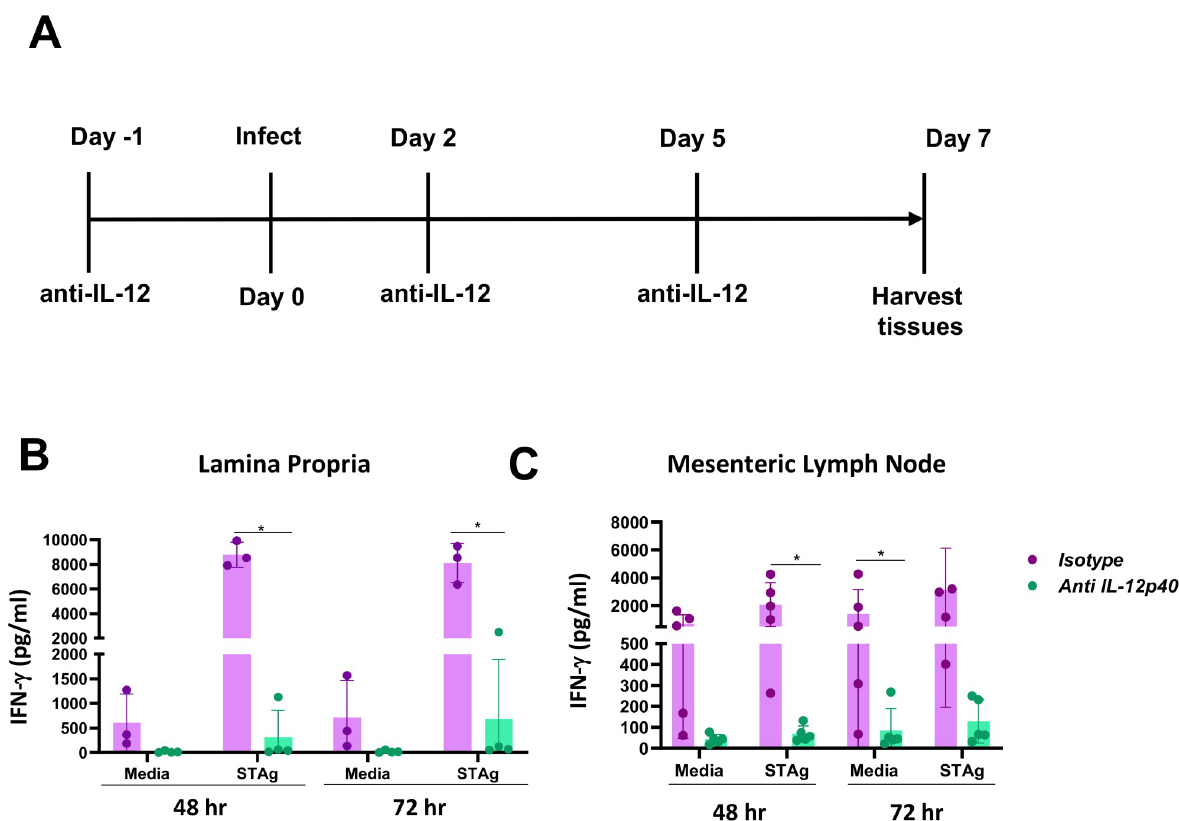
Fig 6. MyD88-independent IFN- γ response requires IL-12. (A) MyD88 -/ - mice were subjected to injections of IL-12p40 neutralizing antibody before and after infection. (B) LP cells and (C) MLN cells were prepared at day 7 post-infection and cultured with media alone or stimulated with STAg for the indicated times. Supernatants were collected and IFN- γ was quantified by ELISA. An independent experiment was performed with similar results. An unpaired Student’s t test was used to analyze the data where � p < 0.05.